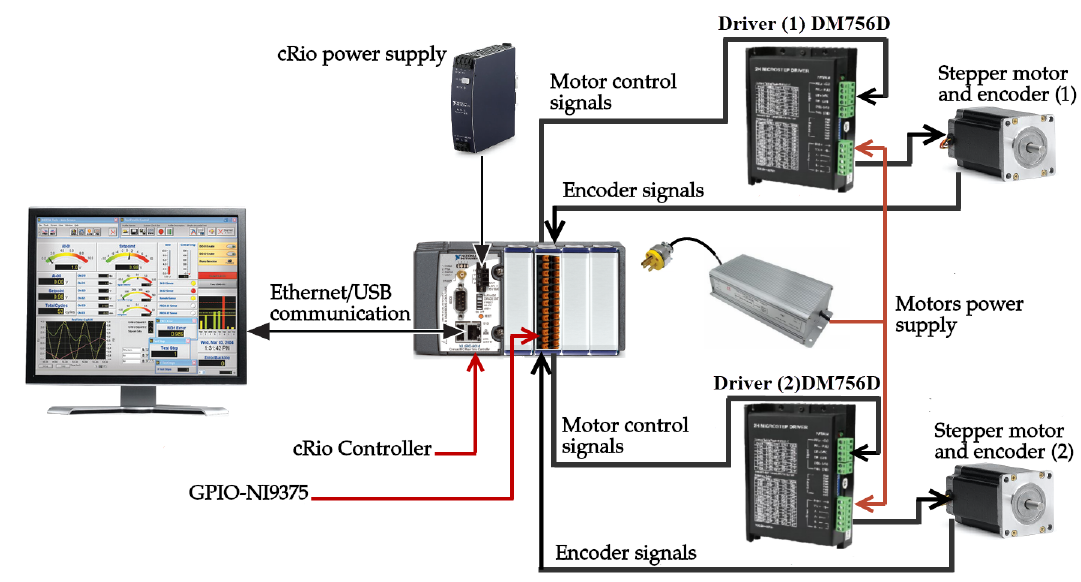
Figure 16. Heliostat array control system diagram.